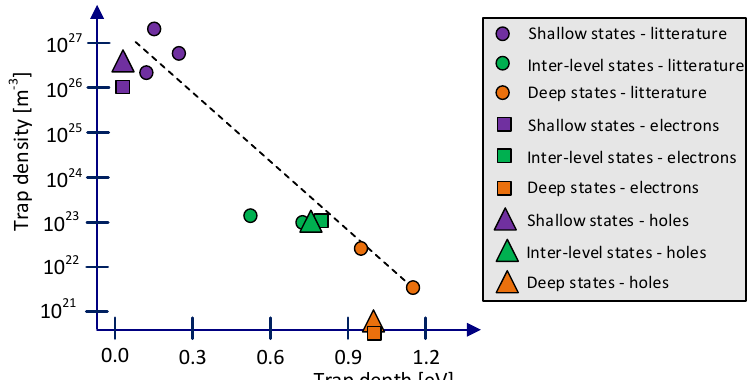
Figure 15. The state distribution adapted from [8] and [12] (circles) and the density–depth relationships for electrons (squares) and holes (triangles) estimated from the parameters found in the calibration.